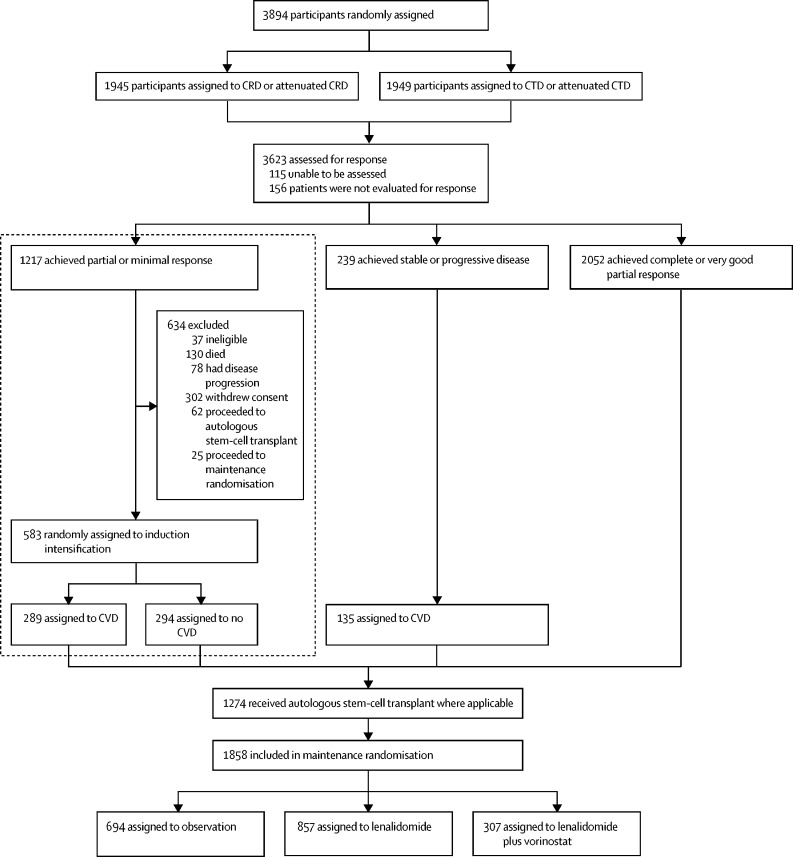
Trial profile of Myeloma XIArea highlighted is the CVD randomisation reported in this manuscript. C=cyclophosphamide. D=dexamethasone. R=lenalidomide. T=thalidomide. V=bortezomib.